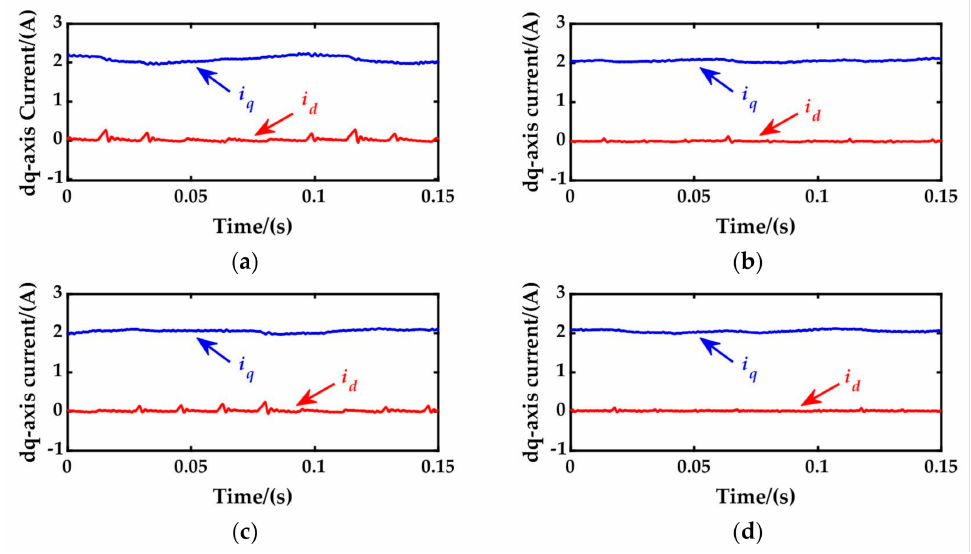
Figure 14. dq –axis currents under i d = 0, 150 r/min and 1N · m load. ( a ) Compensation for PMSM FOC system with conventional DM–CZD. ( b ) Compensation for PMSM FOC system with proposed DP–CZD. ( c ) Compensation for current predictive control of PMSM with conventional DM–CZD. ( d ) Compensation for current predictive control of PMSM with proposed